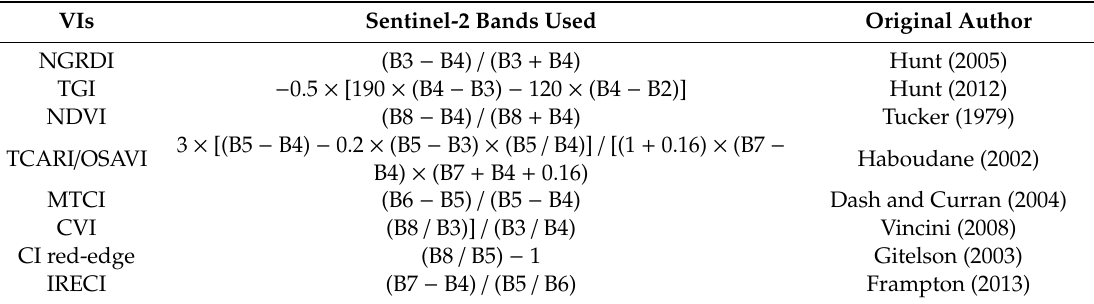
Table 2. An example of some spectral vegetation index (VIs) calculations of interest for use with European Space Agency (ESA) Sentinel-2 satellite data, where B is the spectral reflectance value of the band number of the Sentinel-2 band as detailed in Table